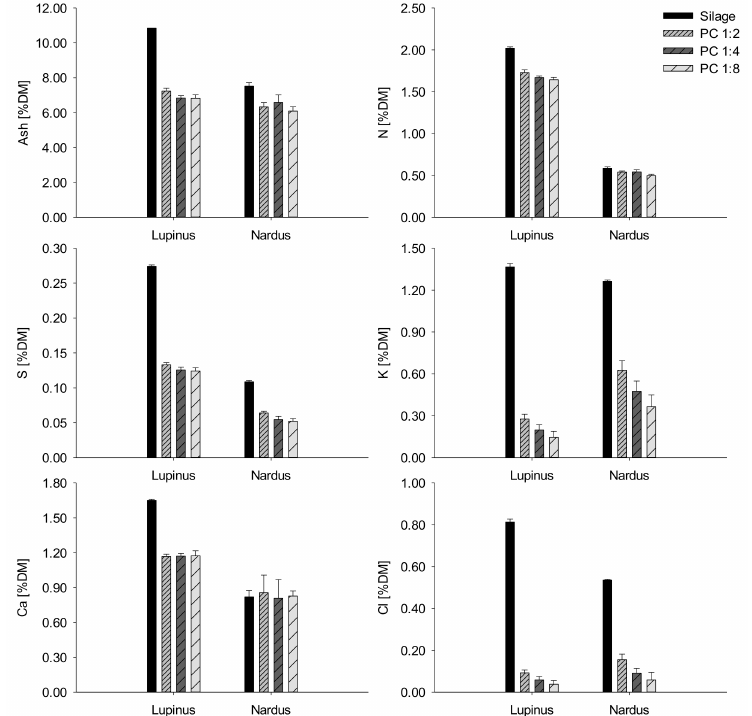
Figure 2. Experiment 2: Mean concentrations of ash, N, S, K, Ca and Cl in silage and PC from grassland dominated by Lupinus polyphyllus (Lupinus) or Nardus stricta (Nardus). The PC was leached with a water to biomass ratio of 1:2, 1:4 or 1:8, respectively. Whiskers display standard errors of the